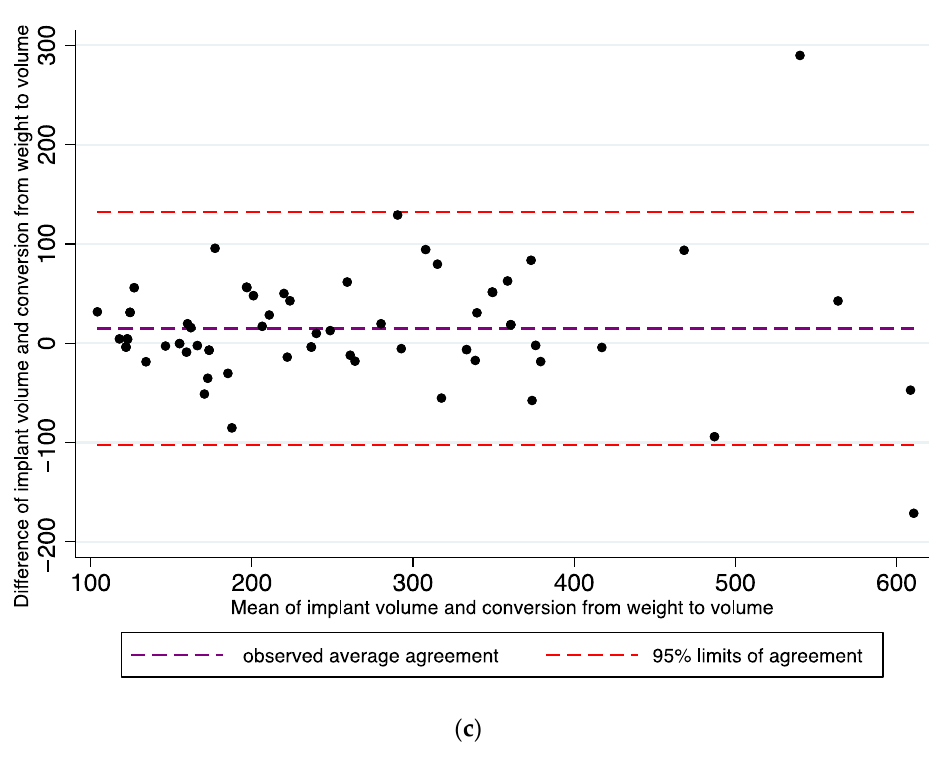
Figure 2. In these figures, the Bland–Altman analysis illustrates the limits of agreement between the volumes of the selected implants and BREAST-V app ( a ), between the volumes of the selected implants and MRI ( b ), and between the volumes of the selected implants and mastectomy weight converted into volumes ( c ).